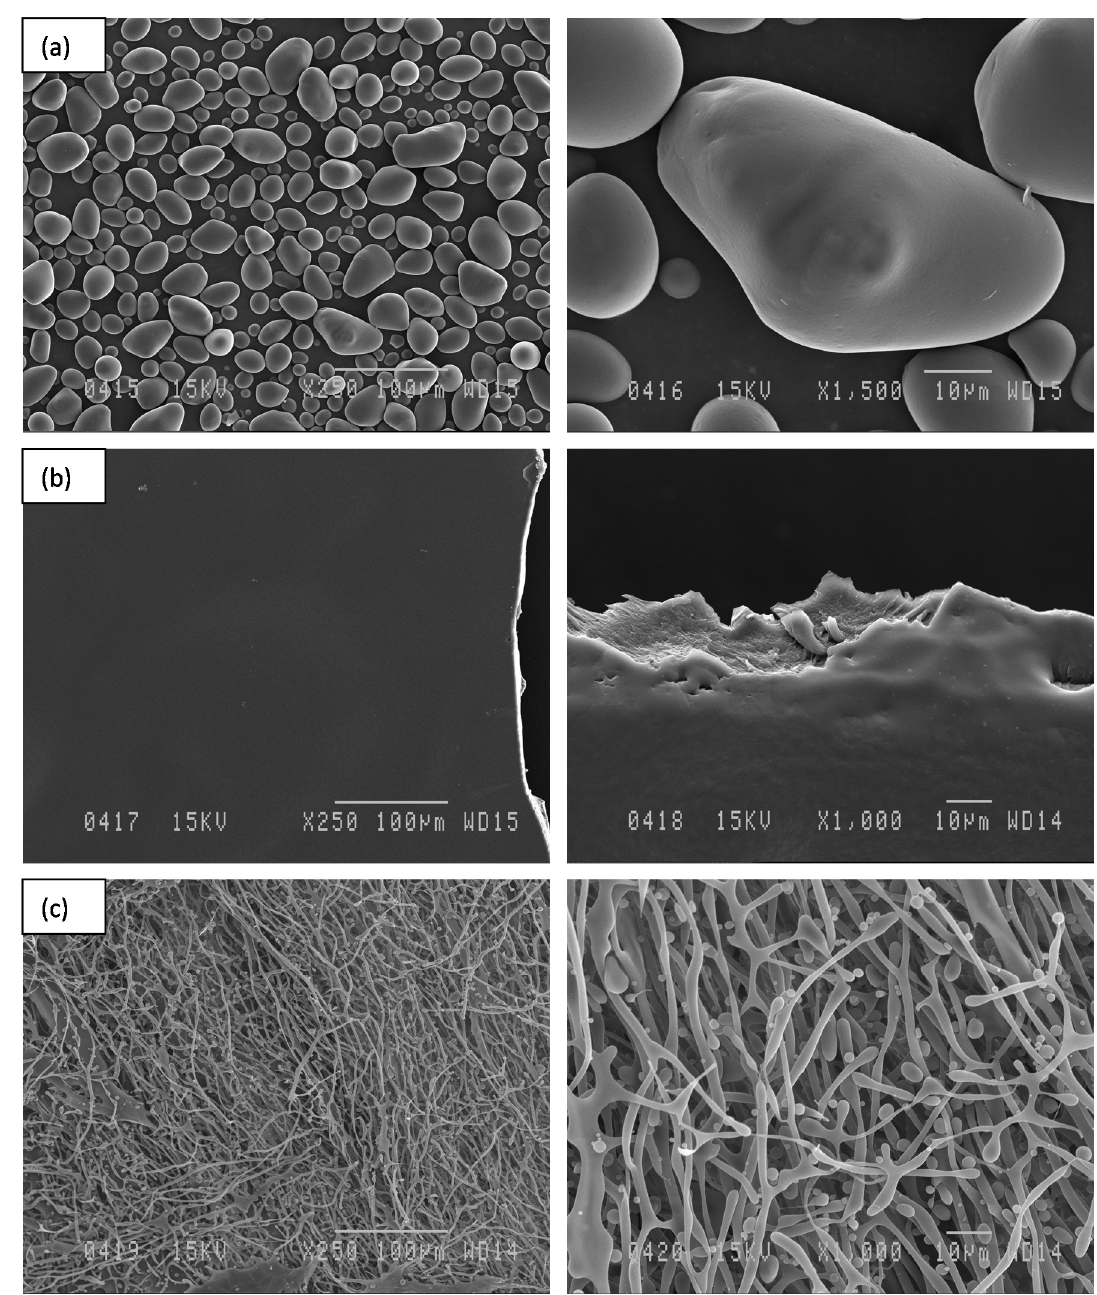
Figure 5. SEM images of potato starch granules treated with ultrasonication under dry conditions ( a ); under wet conditions and dried in a vacuum oven at 40 °C ( b ); under wet conditions and lyophilized ( c ).